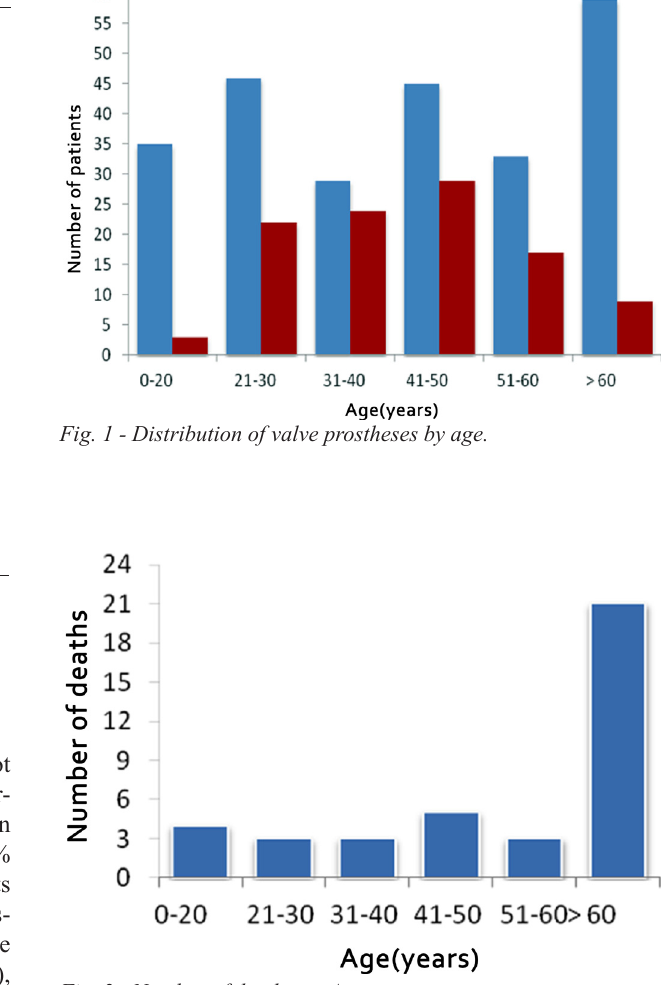
Fig. 2 - Number of deaths vs. Age group.